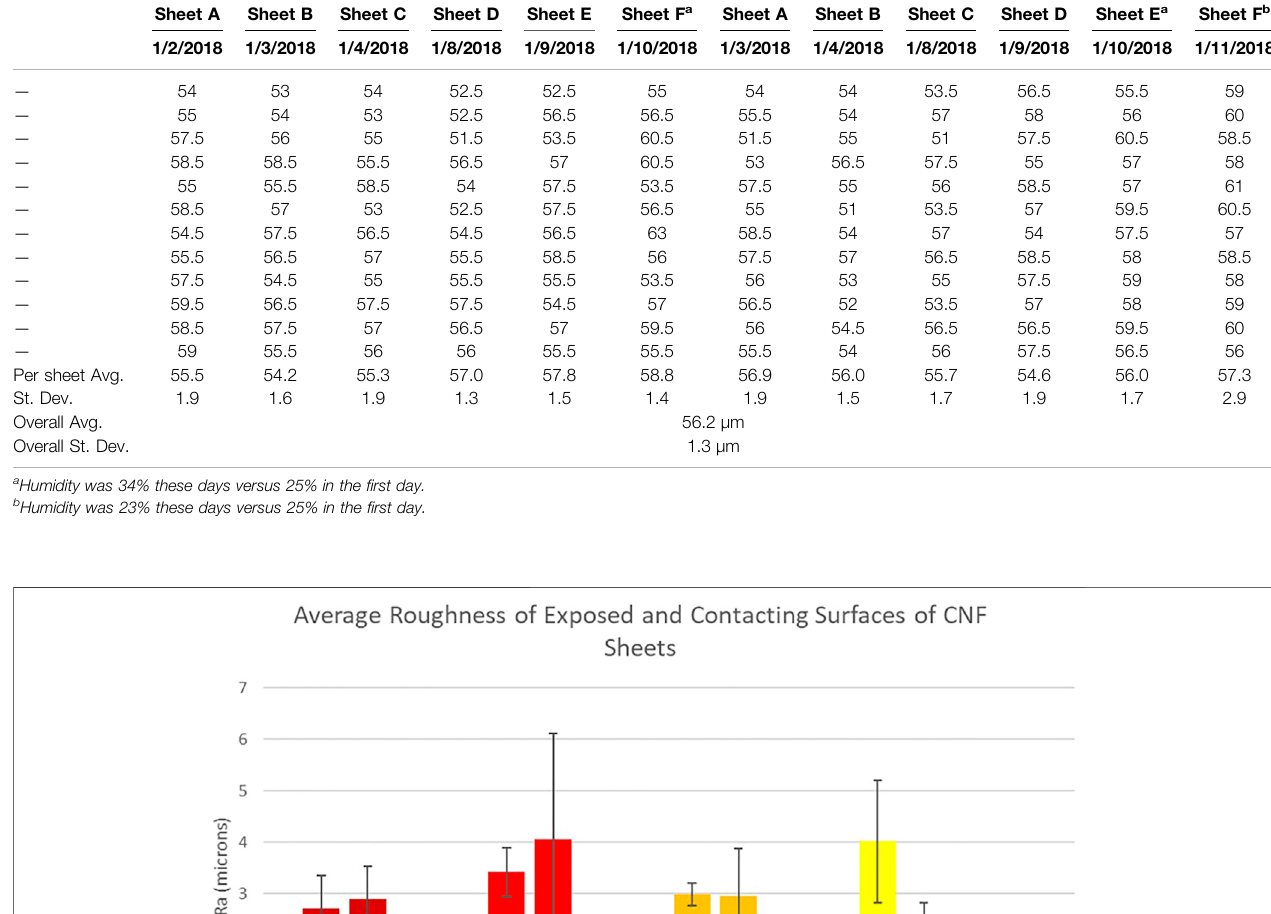
TABLE 1 | Sheet Thickness Analysis. Sheet thickness consistency of 12 CNF sheets cast on two separate stainless steel plates, all values reported in µm. 1st Stainless steel plate